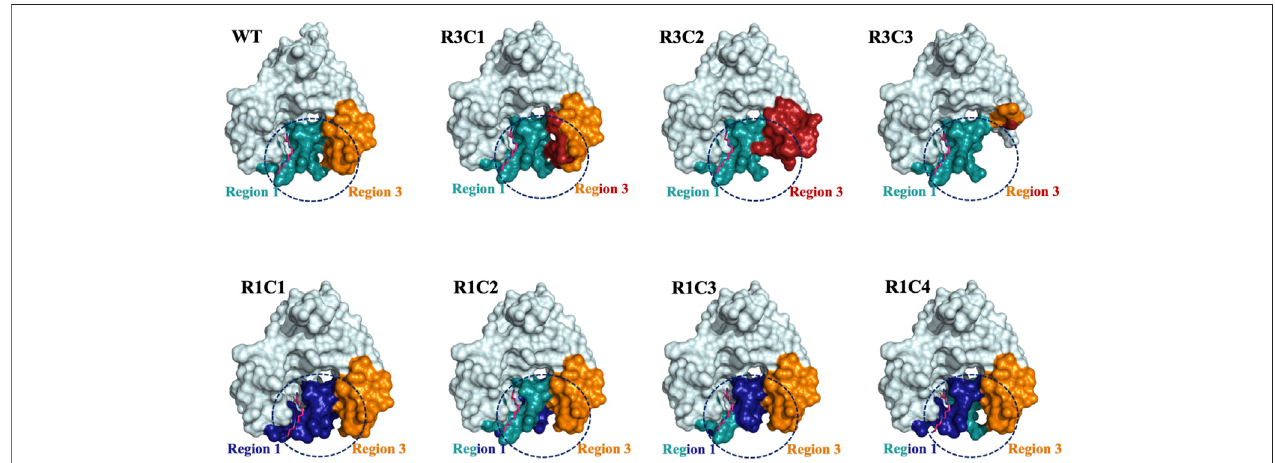
FIGURE 9 | Surface representations of selected Region 1 and 3 constructs. The surface effects of residue substitutions for R1C1-R1C4 and R3C1-R3C3 constructscomparedtotheWTproteinareshown.Thesediagramsarebasedonthehomologymodelsofthespm-boundWTVcSpeGstructure(PDBID:4mi4).Region 1(allostericloop)isshownintealandRegion3isinorangeinallmodelsandtheWTstructure.ResiduesexchangedfromhSSAT1inRegion1areshownindarkblueand residuesexchangedinRegion3areinred.Thedashedcircleemphasizesthesurfacealterationstotheseregionsofallconstructscomparedtothesameareainthe WT VcSpeG